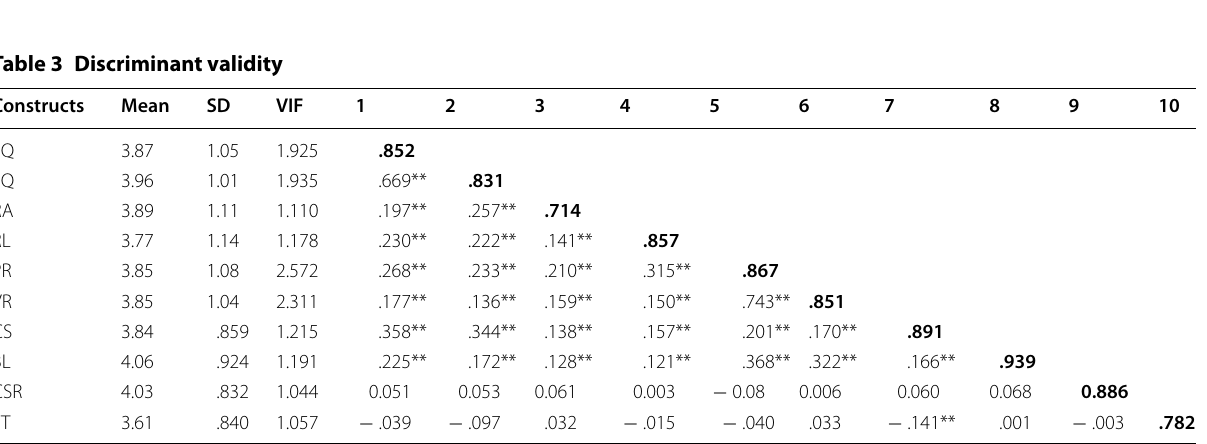
The bold digits in the diagonal are square root of